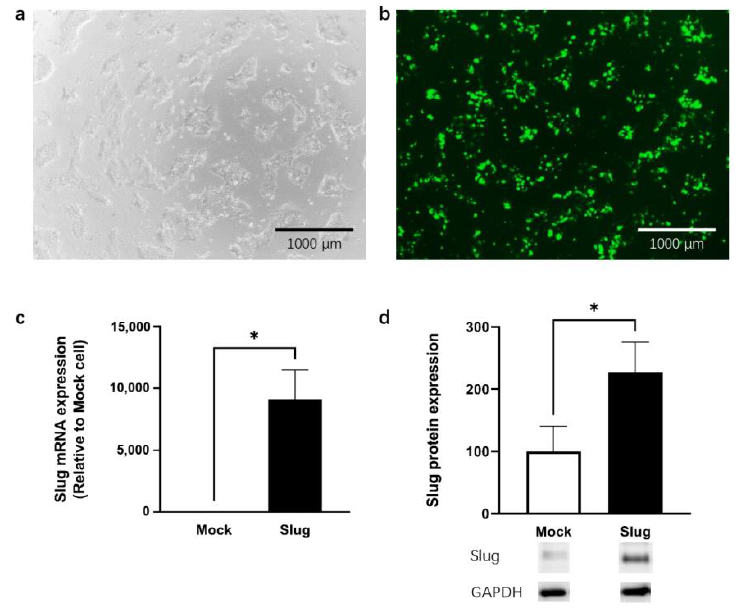
Figure 1. HCC827 cell line was successfully transfected with the Slug plasmid shown on white image ( a ) and fluorescence image ( b ). The results showed a significantly higher expression of Slug mRNA ( c ) and proteins ( d ) than that of the Mock cells (n = 4, * p < 0.05). qRT-PCR and Western blotting data represented the mean ± SD.